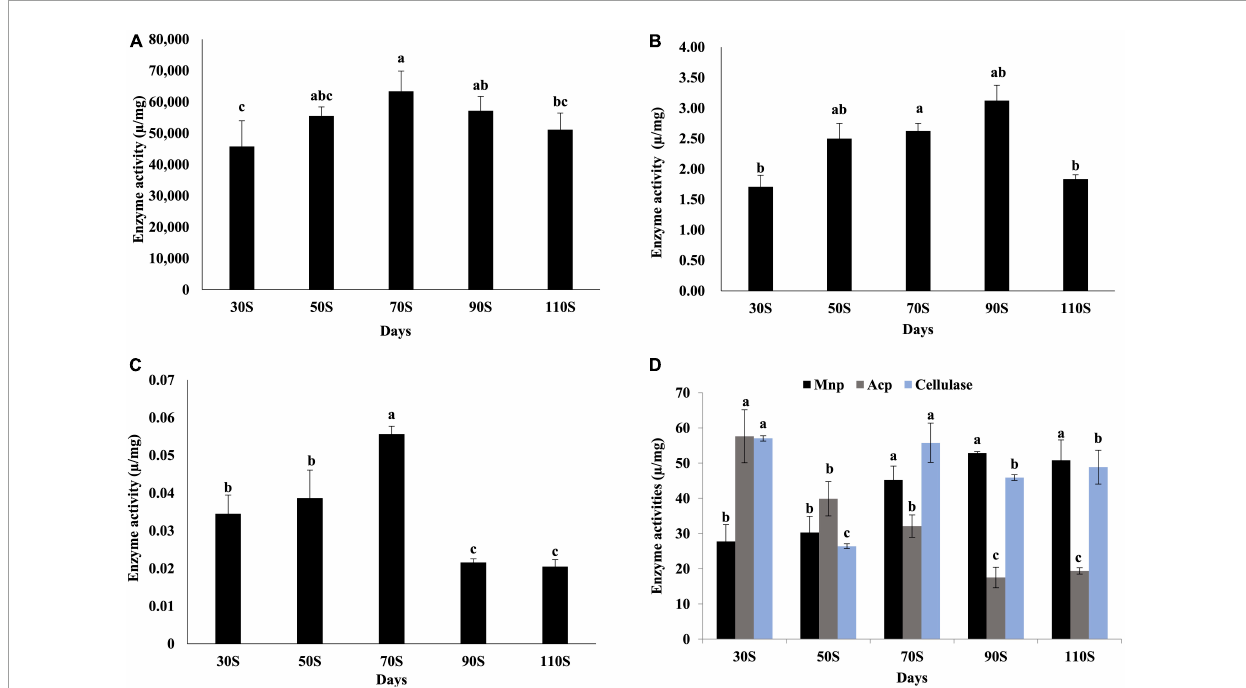
FIGURE7 Activity levels of enzymes involved in nutrient degradation. (A) Laccase, (B) lignin peroxidase, (C) α -amylase, (D) manganese peroxidase, acid protease, and cellulase values are the means of three replicates ± SD. Different letters above columns indicate statistically significant differences between individual enzyme activities at p < 0.05 (ANOVA-LSD, n = 3).